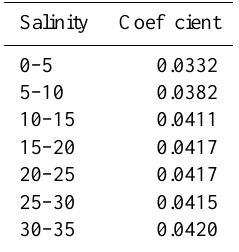
Table 1. Averaged temperature coefficients ( ∂ ln p CO 2 /∂T ) for each salinity bin. Simulated surface water p CO 2 values at varying salinities were computed using river and ocean end-member TA and DIC values of 900 and 960µmolkg − 1 and 2300 and 2000, respec- tively.